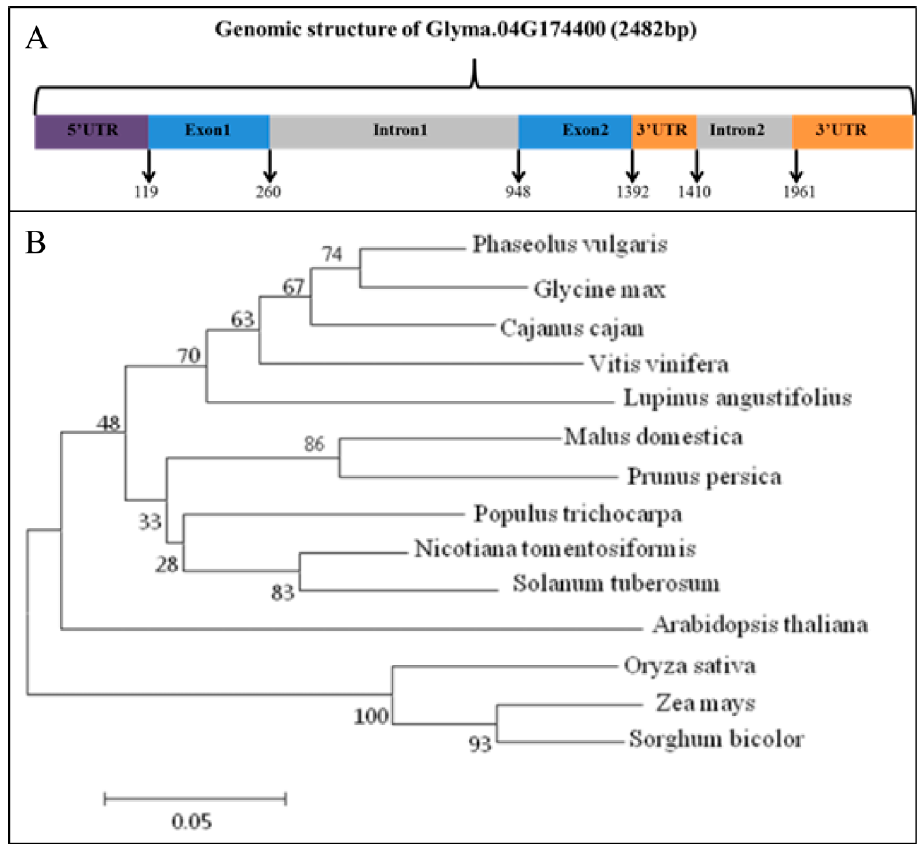
Figure 1. Bioinformatic analyses of GmRIQ2-like . ( A ) Genomic sequence structure of GmRIQ2-like. ( B ) Phylogenic analysis of GmRIQ2-like , which involved 14 amino acid sequences. In the phylogenetic tree, taxon names were replaced by the species name. Evolutionary analyses were conducted in MEGA5.0.